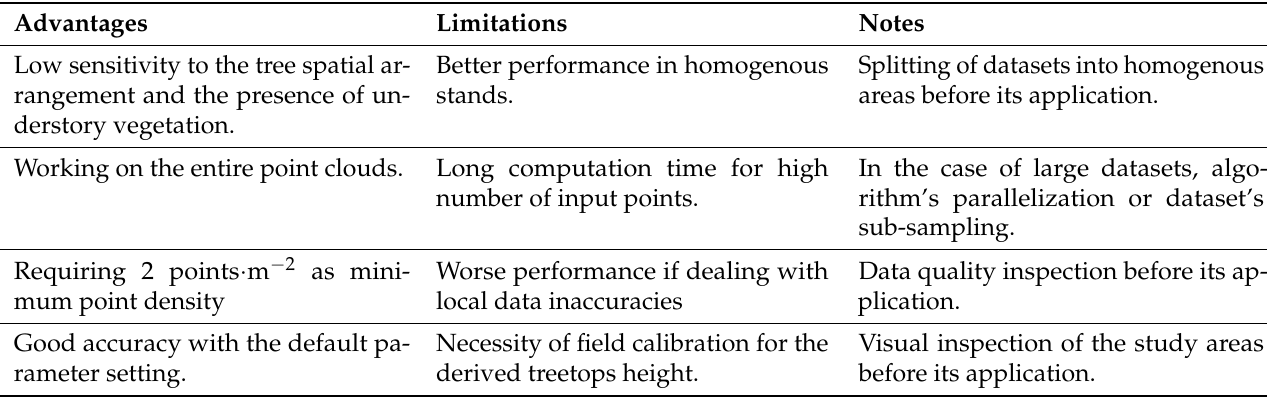
Table 5. Summary of the main advantages and limitations of the presented algorithm along with notes for its application. Advantages Limitations rangement and the presence of un- stands. derstory vegetation. Working on the entire point